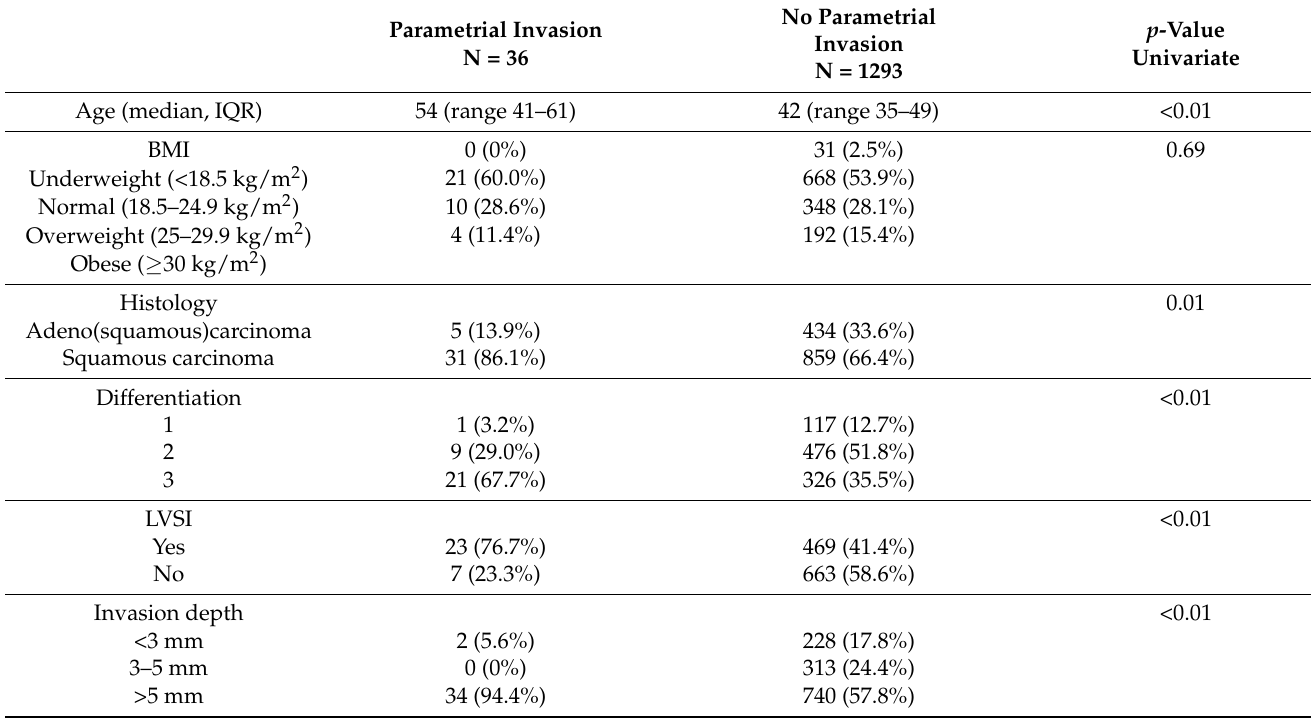
Table 3. Parametrial invasion and clinical characteristics in patients who underwent a parametrec- tomy.